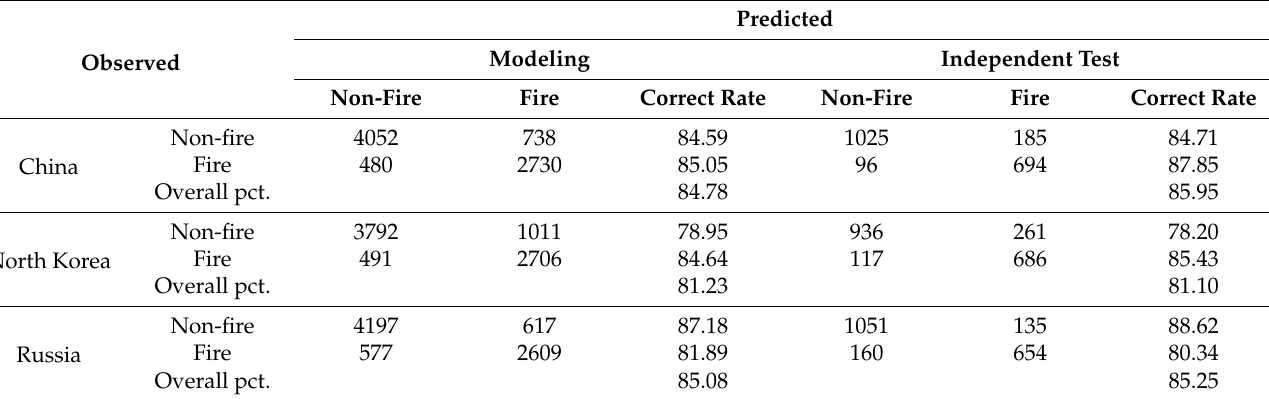
Table 6. Prediction accuracy results for modeling samples and independent testing